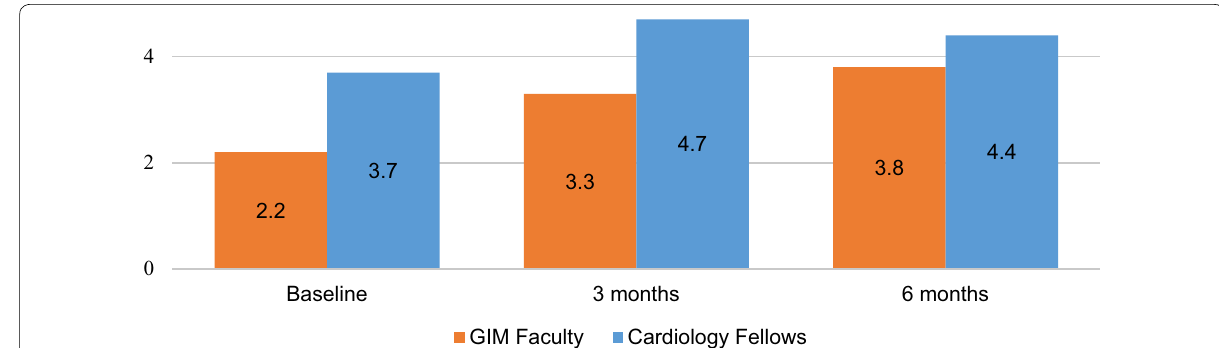
Fig. 2 Focused cardiac ultrasound efficiency scores for GIM faculty and cardiology fellows. Baseline line assessment occurred after GIM faculty completed an introductory point-of-care ultrasound workshop. There were no significant differences between the two groups at any of the three assessments